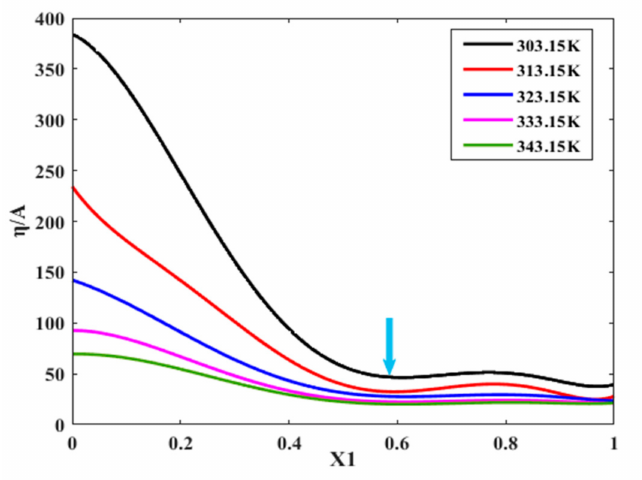
Figure 8. Optimization curves of viscosity/absorption and molar fraction of ([EMIM] [TFA] + TEA). Taking the result at 303.15 K as an example, the results show that the function has a minimum value of 44.80 when the molar fraction of [EMIM] [TFA] is 0.58, the viscosity is 35.51 mPa · s, and the adsorption capacity is 0.7927 g · g − 1 , at this time ([EMIM] [TFA] +